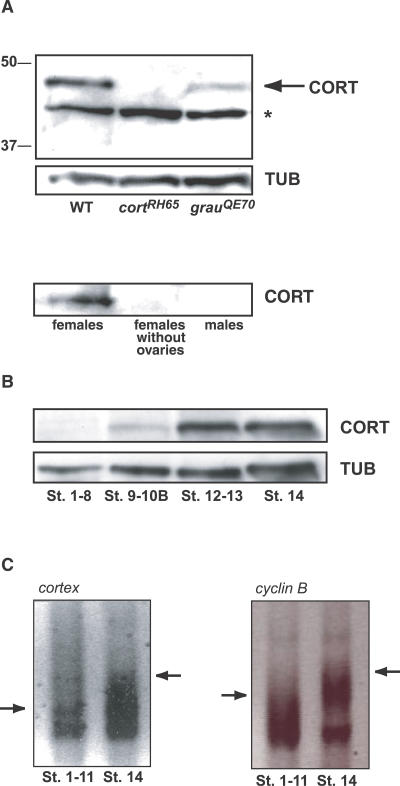
The Appearance of CORT Protein in Mature Oocytes Correlates with Polyadenylation of cort mRNA(A) Top panel: Characterization of CORT antibody. Western blot showing that anti-CORT serum recognizes a band of approximately 47 kDa in wild-type oocyte extracts. The band is absent in cortRH65 mutant oocyte extracts and reduced in grauQE70 mutant oocyte extracts. The blot was probed with anti-α-Tubulin as a loading control. Asterisk marks a nonspecific protein that reacts with anti-CORT serum. Size markers in kilodaltons are shown on left side of blot. Bottom panel: CORT expression is specific to oogenesis. Western blot shows presence of CORT in whole female fly extracts but absence from whole female extracts from which the ovaries were removed or from whole male extracts.(B) Developmental western blot of CORT in developing egg chambers. Endogenous CORT levels are low to undetectable in immature ovaries (stages 1–10B), but strongly increase in mature oocytes (stages 13–14). Extracts were made from hand-dissected ovaries. By ImageJ analysis, band intensity of CORT in stages 12–13 is 3.6-fold greater and in stage 14 3.5-fold greater than that of CORT in stage 9–10B. The blot was probed with anti-α-Tubulin as a loading control.(C) PAT assays showing elongation of poly(A) tail lengths of cortex and cyclin B mRNA upon oocyte maturation in wild-type ovaries (transition from immature stage 1–11 egg chambers to mature stage 14 oocytes). Arrows indicate the top of each poly(A) smear.